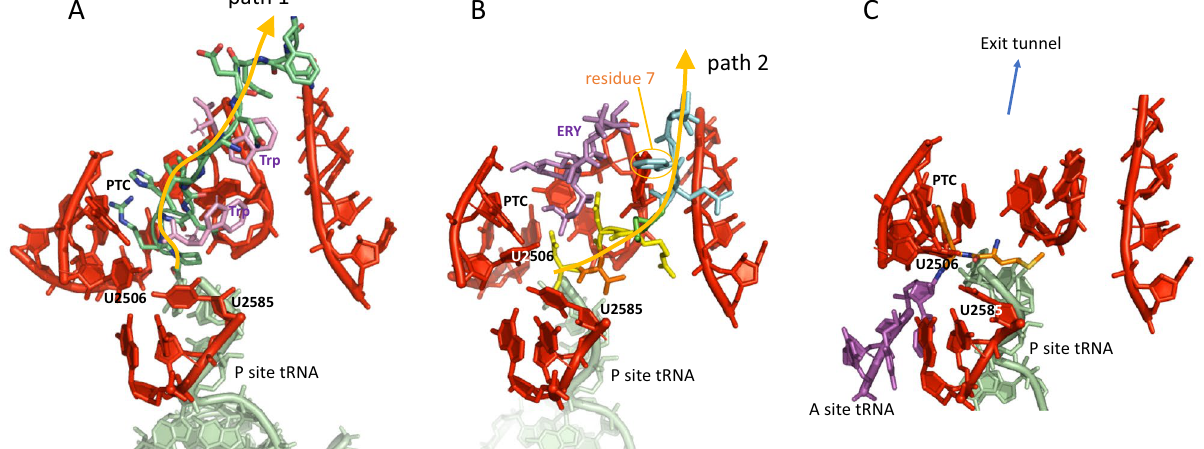
Figure 4. Arrest peptides and dipeptidyl-tRNA the ribosome. ( A ) Trp-arrest peptide following path 1, with peptidyl-tRNA on the P site and two bound tryptophan (Trp) (pdb 4UY8 21 ). ( B ) Erythromycin-arrest peptide following path 2, with peptidyl-tRNA on the P site and a bound erythromycin (ERY) (pdb 5JU8 11 ). Amino acid No. 7 (Phe, highlighted) is at the level of U2609 (in the foreground, not shown). ( C ) Dipeptidyl-tRNA on the A site of the ribosome (pdb 1VY5 18 ). Path 1 and 2 are discussed in Arenz et al. 11